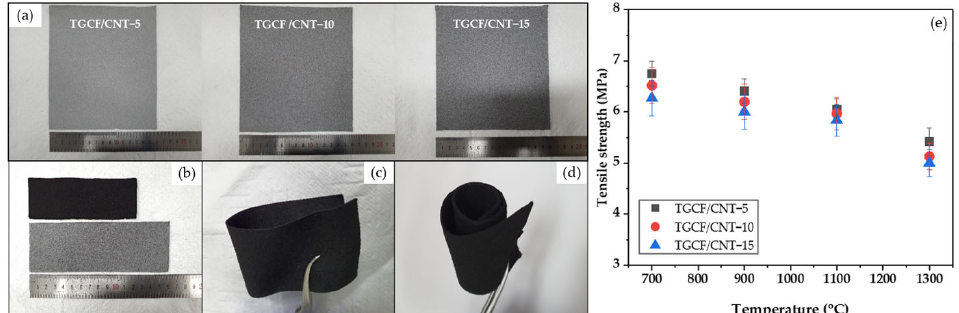
Figure 6. Photographs of TGCF/CNT papers: ( a ) with different carbon-nanotube (CNT) contents before carbonization; ( b ) after and before carbonization, showing shrinkage TGCF/CNT carbon paper before and after carbonization; ( c ) bending of the TGCF/CNT carbon paper; ( d ) winding of the TGCF/CNT carbon paper. ( e ) Tensile strength of the TGCF/CNT carbon papers according to carbonization temperature and CNT content.